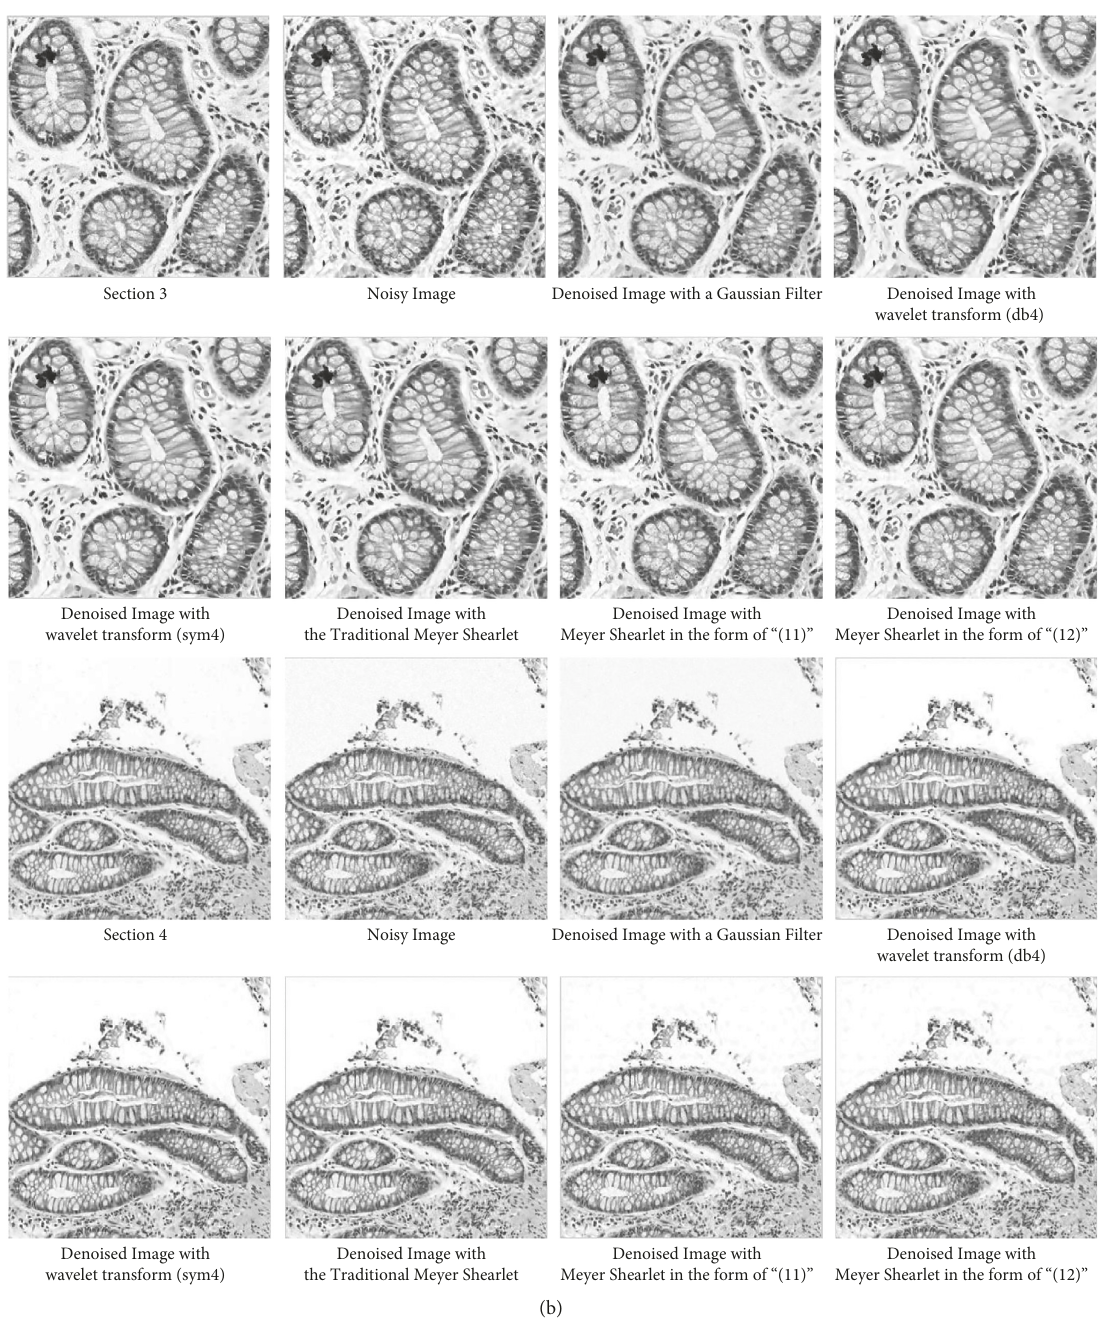
Figure 3: Denoised images of different algorithms for pathological sections of the